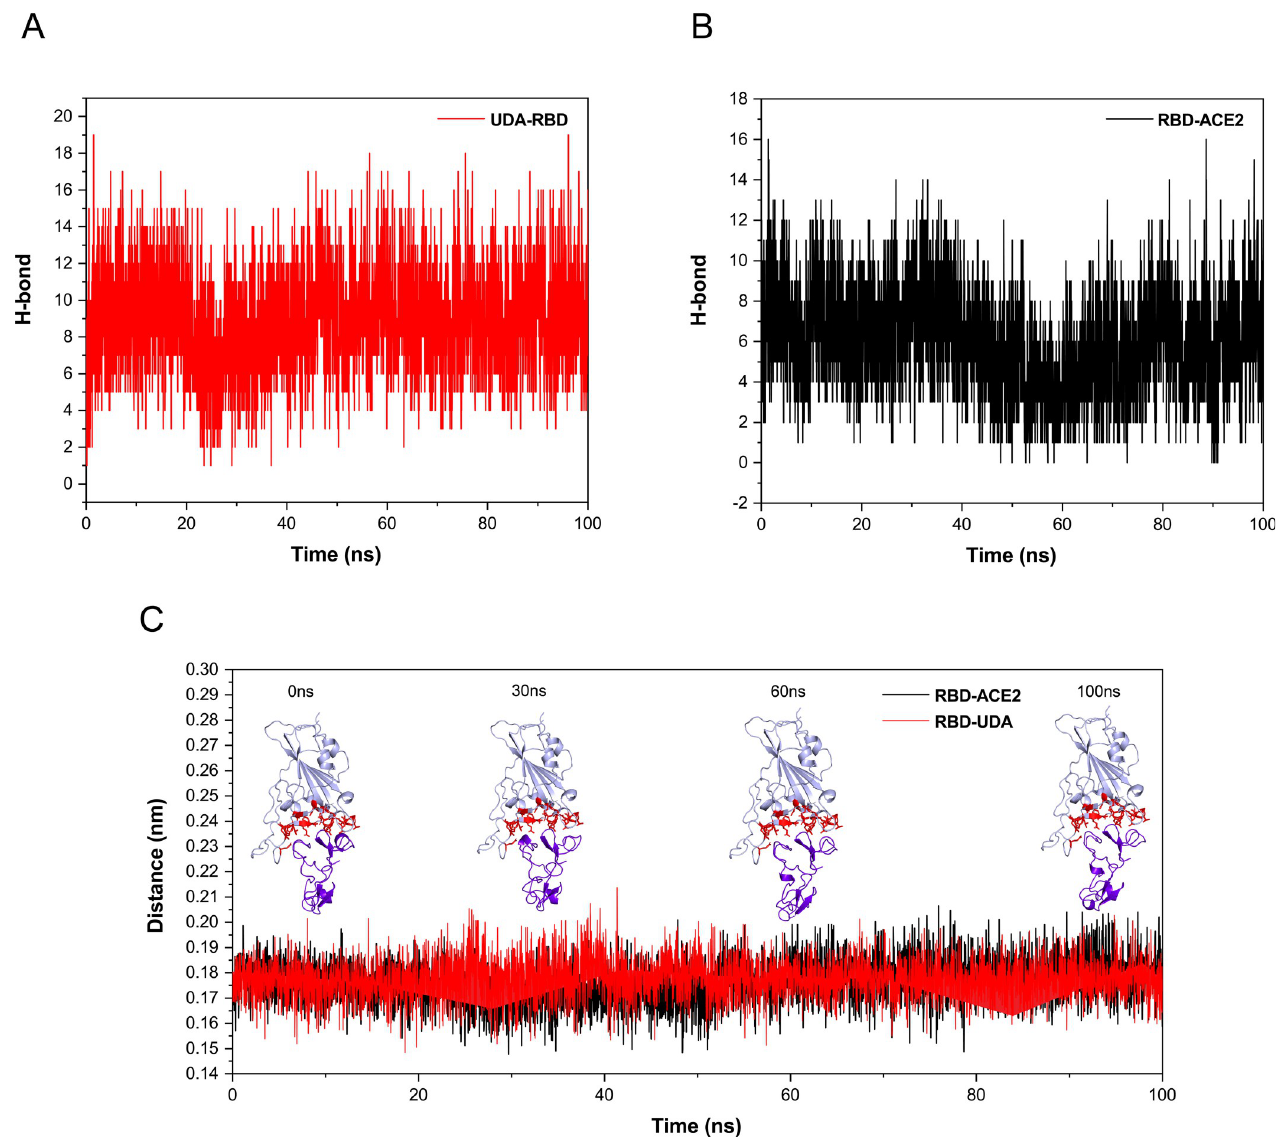
Fig 7. The plots of intermolecular hydrogen bonds between active sites of RBD-UDA (a) and RBD-ACE2 during 100 ns of molecular dynamic simulations (b). The change of distance between centers of active sites UDA and RBD (red) and ACE2 and RBD (black) over the period of 100 ns